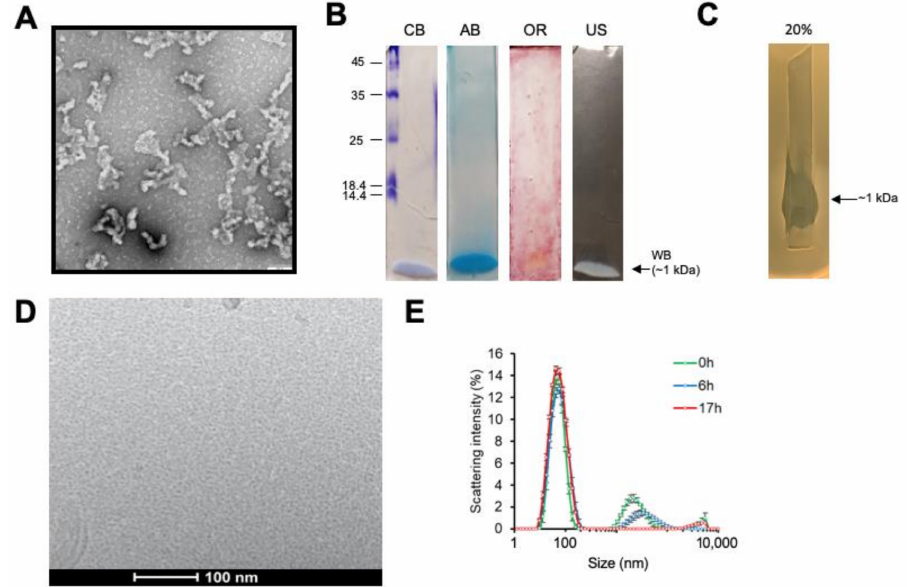
Figure 2. Activity corresponds to low MW species. ( A ) TEM analysis of AmSO 4 precipitated material (20%), scale bar = 100 nm. ( B ) Staining of the 20% AmSO 4 material run on 12.5% SDS-PAGE